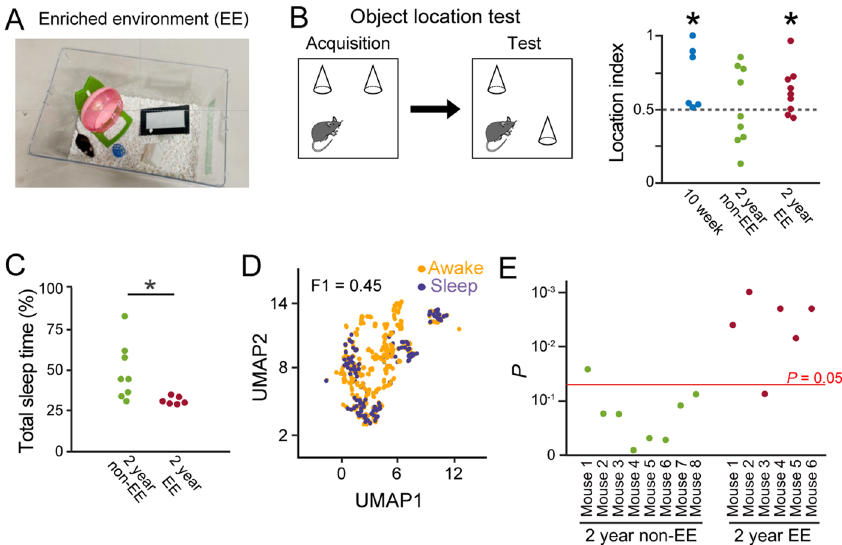
Figure 4. EE restores sleep-related neuronal activity in aged mice . ( A ) A photograph of the EE. ( B ) (Left) Schematic diagram of an object location test. (Right) Location index in the object location test ( n = 6, 9, and 9 mice). Each dot represents an individual mouse. * P < 0.05, Wilcoxon signed rank test versus 0.5 (dotted line). ( C ) The percentage of sleep periods to total recording periods ( n = 7, 8, and 6 mice). The plots in the 2-year non-EE groups are similar to those shown in Fig. 1e, presented for comparison. * P < 0.05, Mann–Whitney U test. ( D ) Same as Fig. 3e but for a representative 2-year EE mouse. ( E ) For individual mice, P values for original F1 scores were computed from datasets including all six frequency bands. The horizontal red line indicates P = 0.05, showing the significance. MATLAB R2021b (https:// jp. mathw orks. com/ produ cts/ new_ produ cts/ relea se202 1b. html), Illustrator 26.2.1 (https:// www. adobe. com/ jp/ produ cts/ illus trator. html) and Python 3.10.4 (https:// www. python. org/ downl oads/ relea se/ python- 3104/) were used to create this